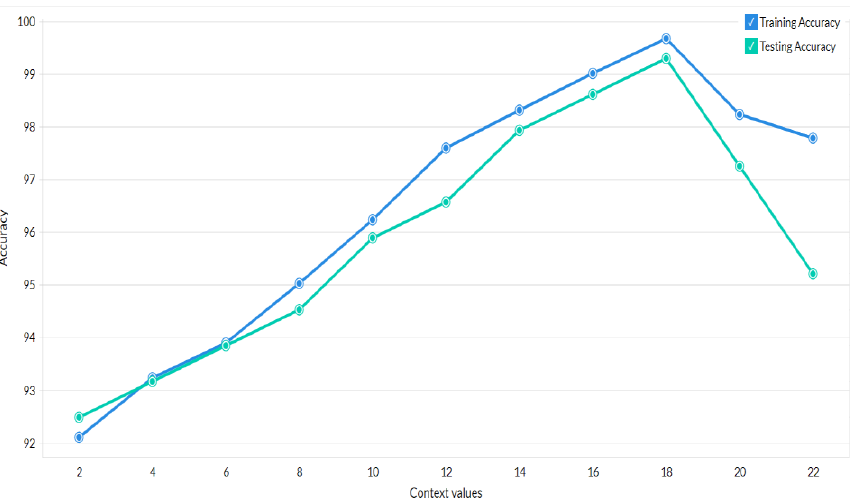
Figure 8. Determining the Context value.